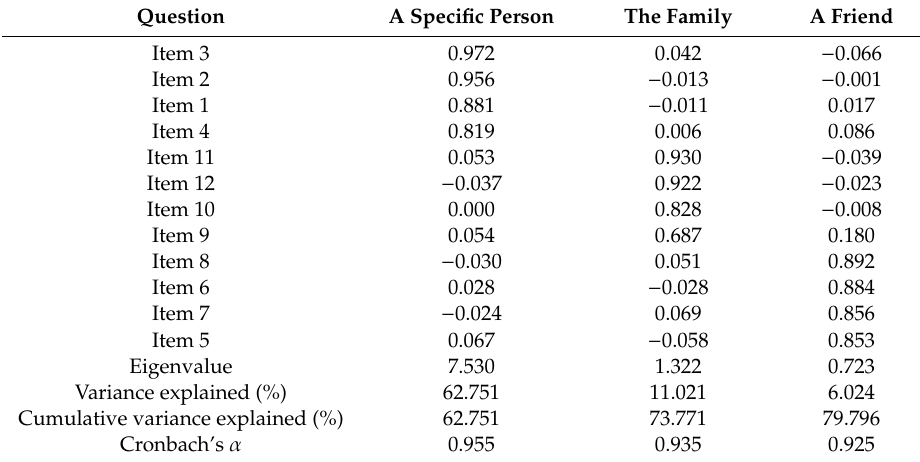
Table 2. Exploratory factor analysis of social